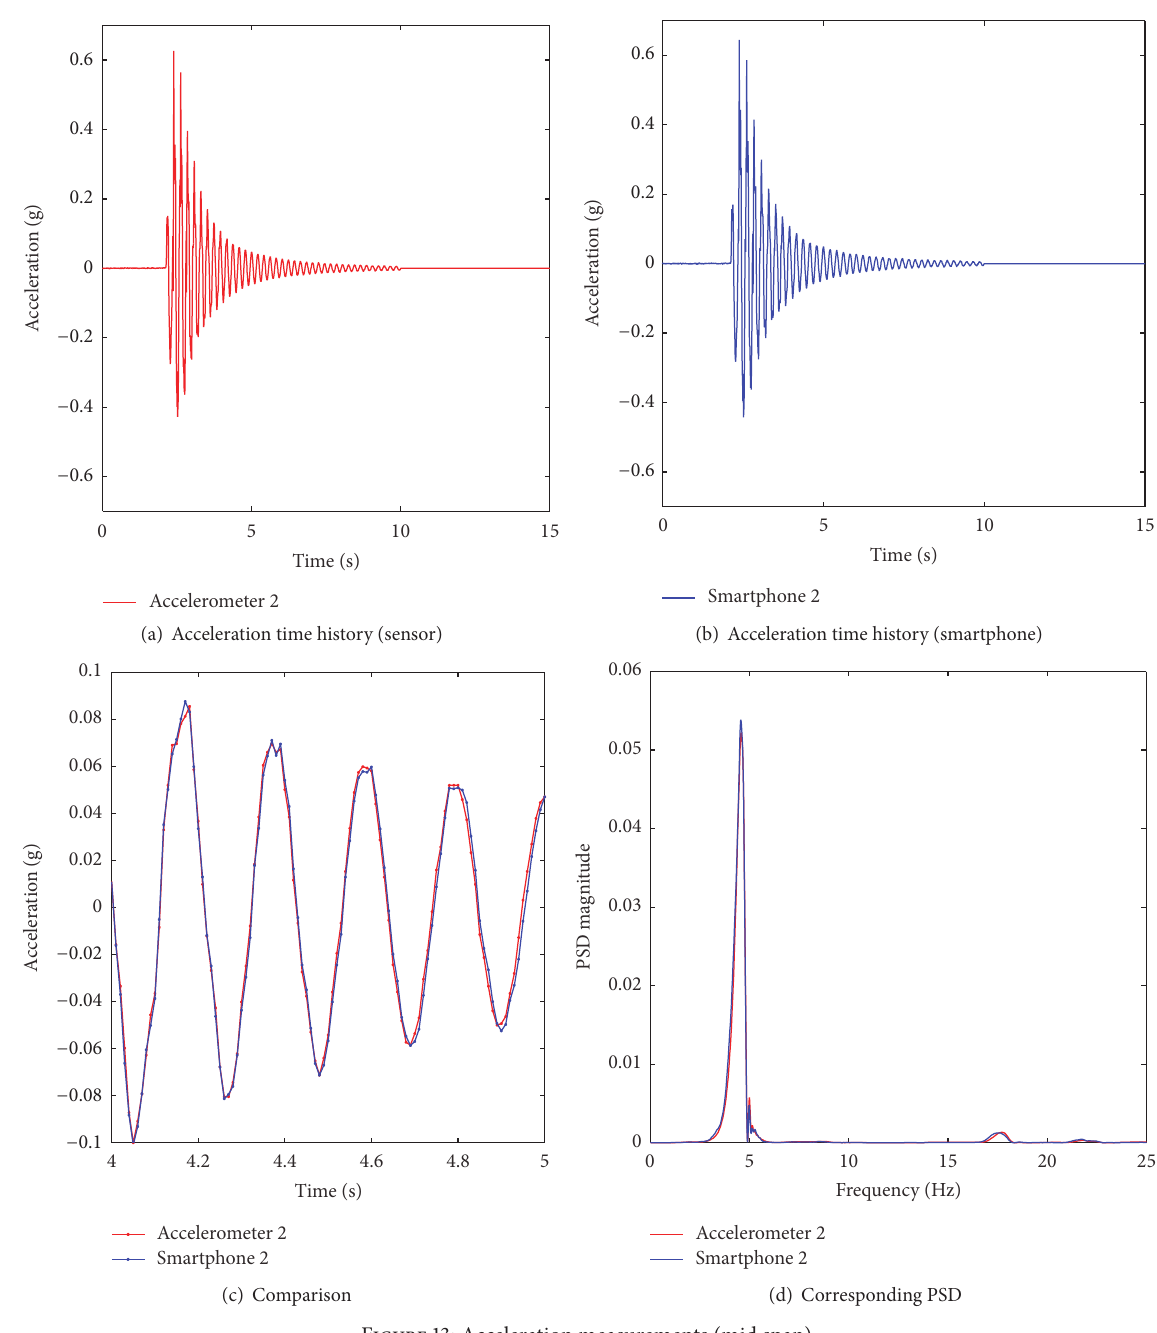
Figure 13: Acceleration measurements (mid span).